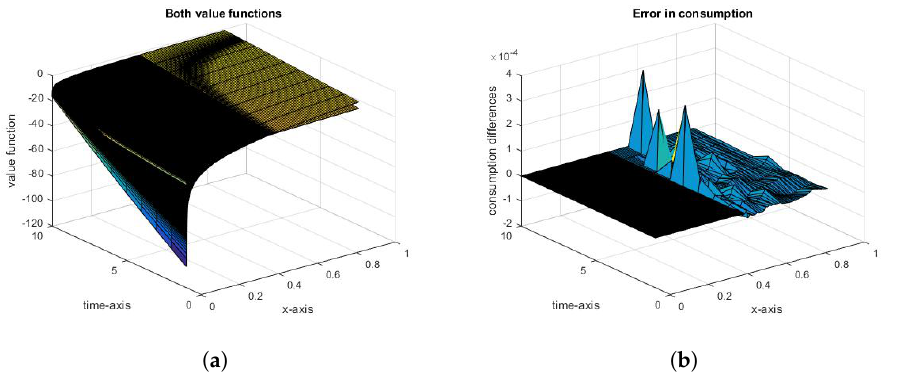
Figure 4. (In-)accuracy of the value function of a players versus the accuracy of the Nash equilibrium strategy. ( a ): Numerical and actual value functions, V N ( t , x ) , for the Nash equilibrium; ( b ): The error in c N ( t , x ) (difference between numerical and actual values) for the Nash